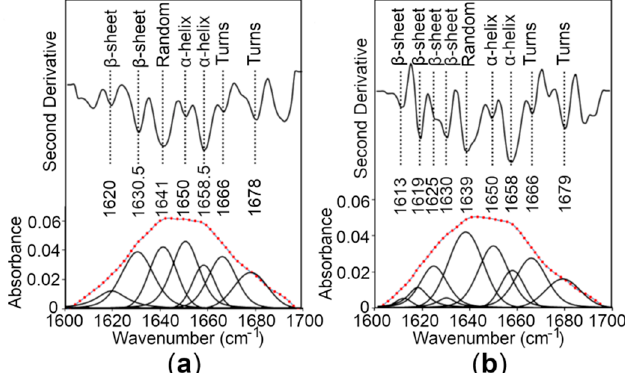
Figure 4. Circular dichroism (CD) spectroscopy of the hZnT8 CTDs. ( a,b ) CD spectra of the WT CTD ( a ) and the R325W CTD ( b ) in the absence (black continuous lines) and in the presence (red dotted lines) of 1 mM Zn +2 . Blue dotted lines represent the CD spectra of the CTDs that were heated up to 90 °C followed by an attempt of refolding upon cooling to 25 °C.